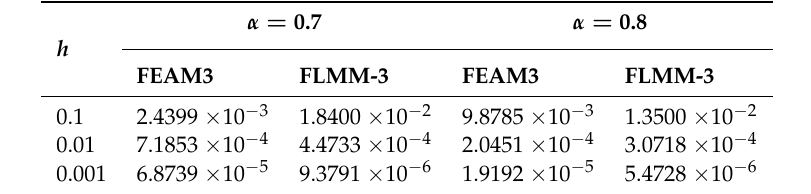
Table 5. Absolute error at t = 1 at different α and step size, h using FEAM3 and FLMM-3 in solving Example 2.